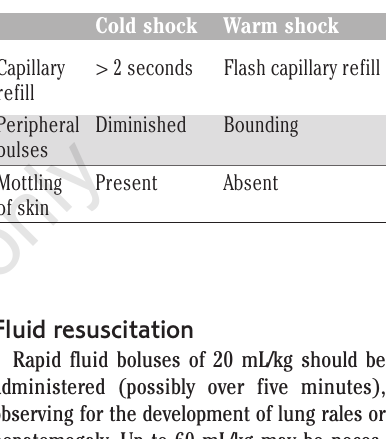
Table 2. Clinical characteristics of cold and warm shock (modified from Saladino et al . 14